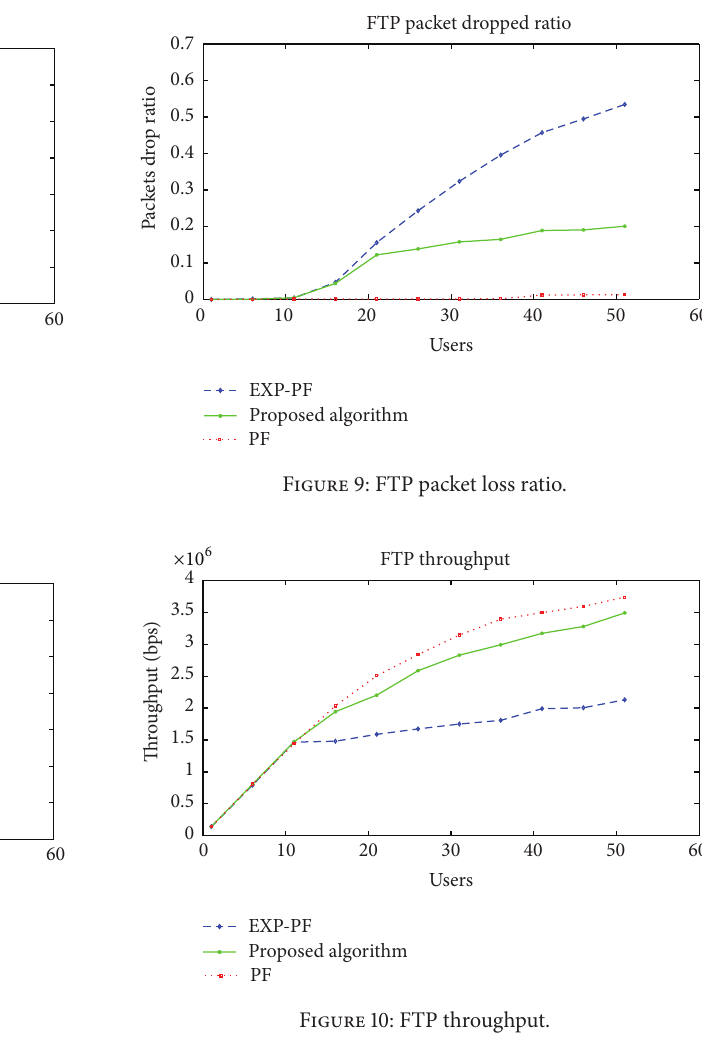
Figure 8: FTP traffic received.